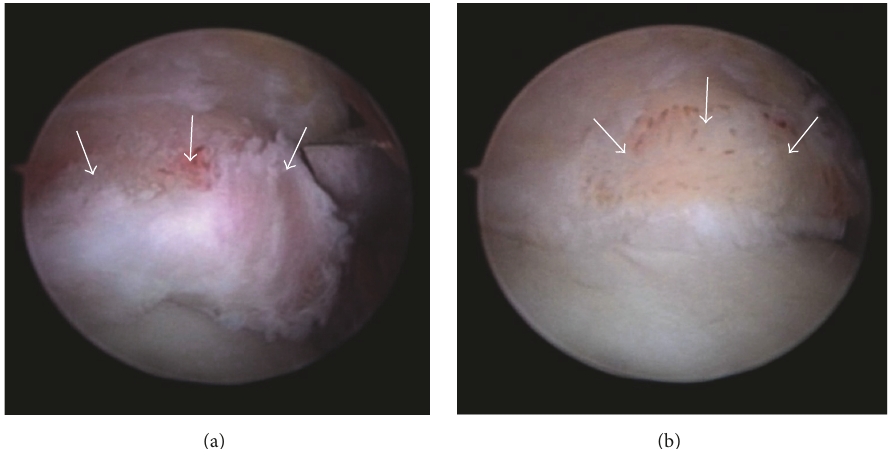
Figure 2: Photographs taken during ankle arthroscopy showing (a) large osteophytes at the anterior edge of the distal tibial end (arrow). (b) After excision using a bone cutter